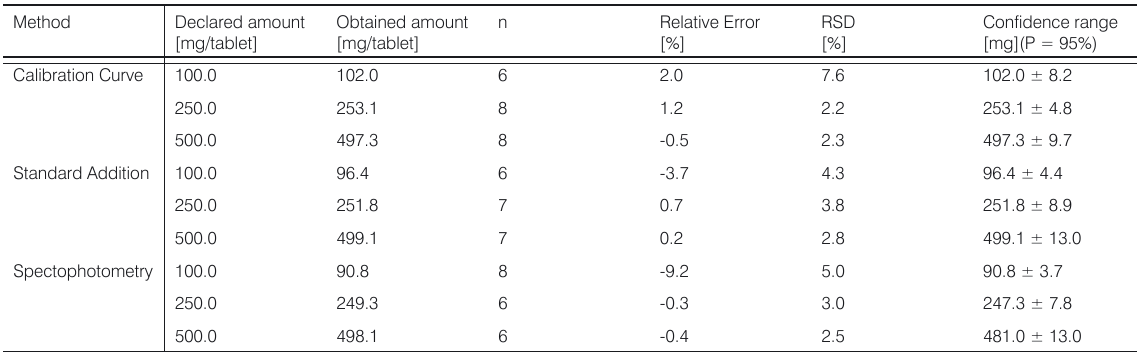
Table 5. Naproxen determination.